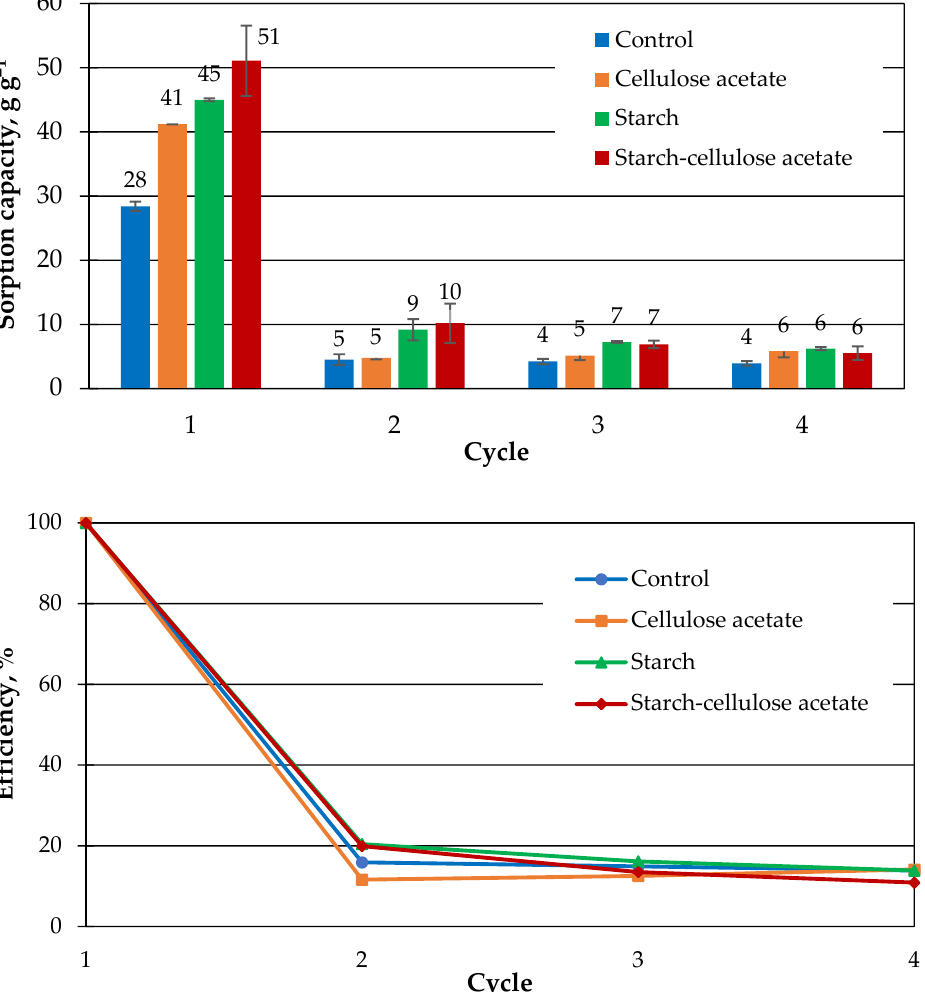
Figure 8. Results of the aerogels with different cross-linkers maximum MDO sorption capacity ( upper figure ) and reuse efficiency of the samples on MDO by each cycle ( lower figure ).